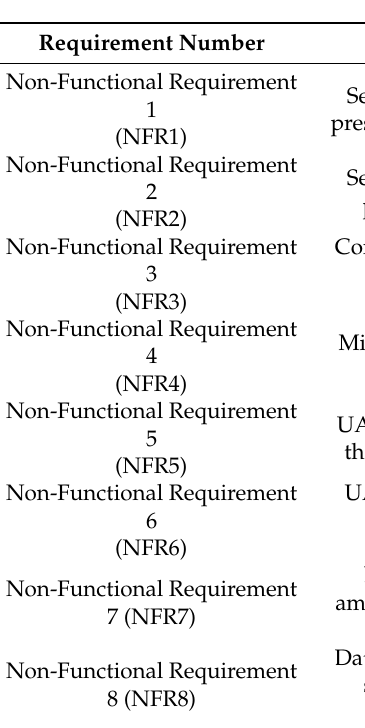
Table 5. List of the UAV non-functional requirements, as obtained from studied literature and questions formulated to